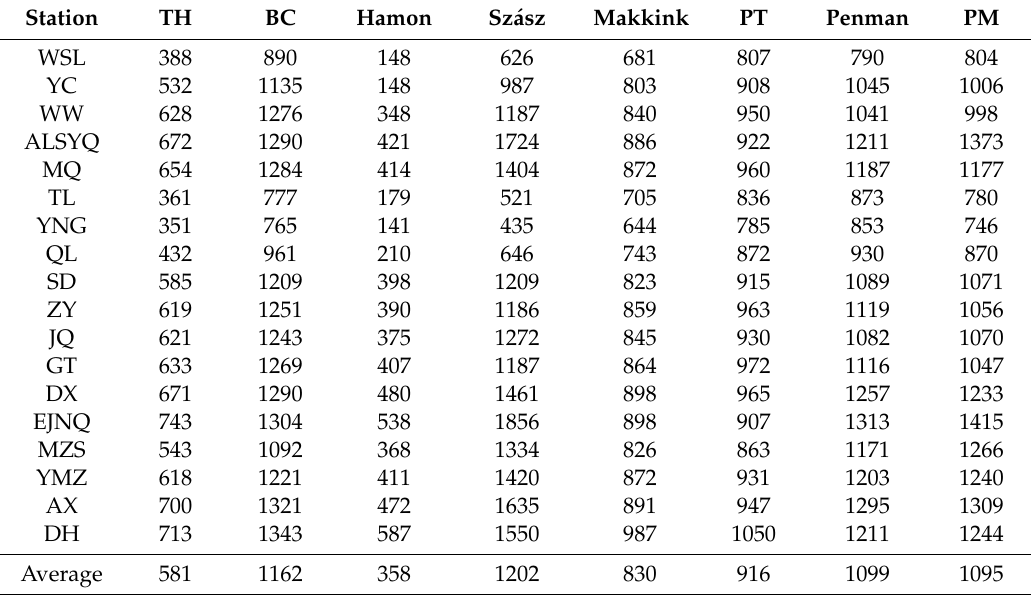
Table 6. Annual PET values calculated by di ff erent models in HIRB